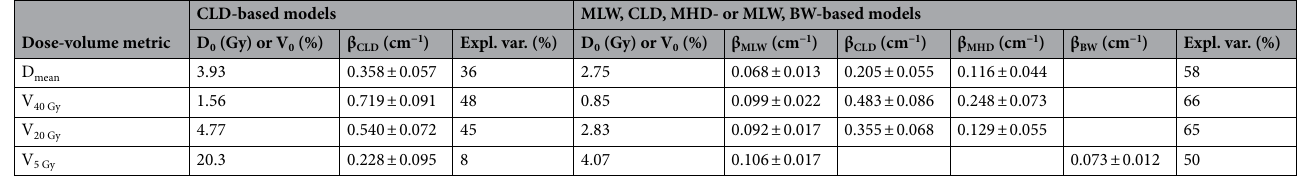
Table 2. Summary of GLM models (Eq. (1)) and fraction of individual variability explained for selected dose- volume characteristics of the ipsilateral lung resulting from whole-breast irradiation using 3DCRT without wedges in left-sided patients. Model coefficients are reported as best estimates and their standard